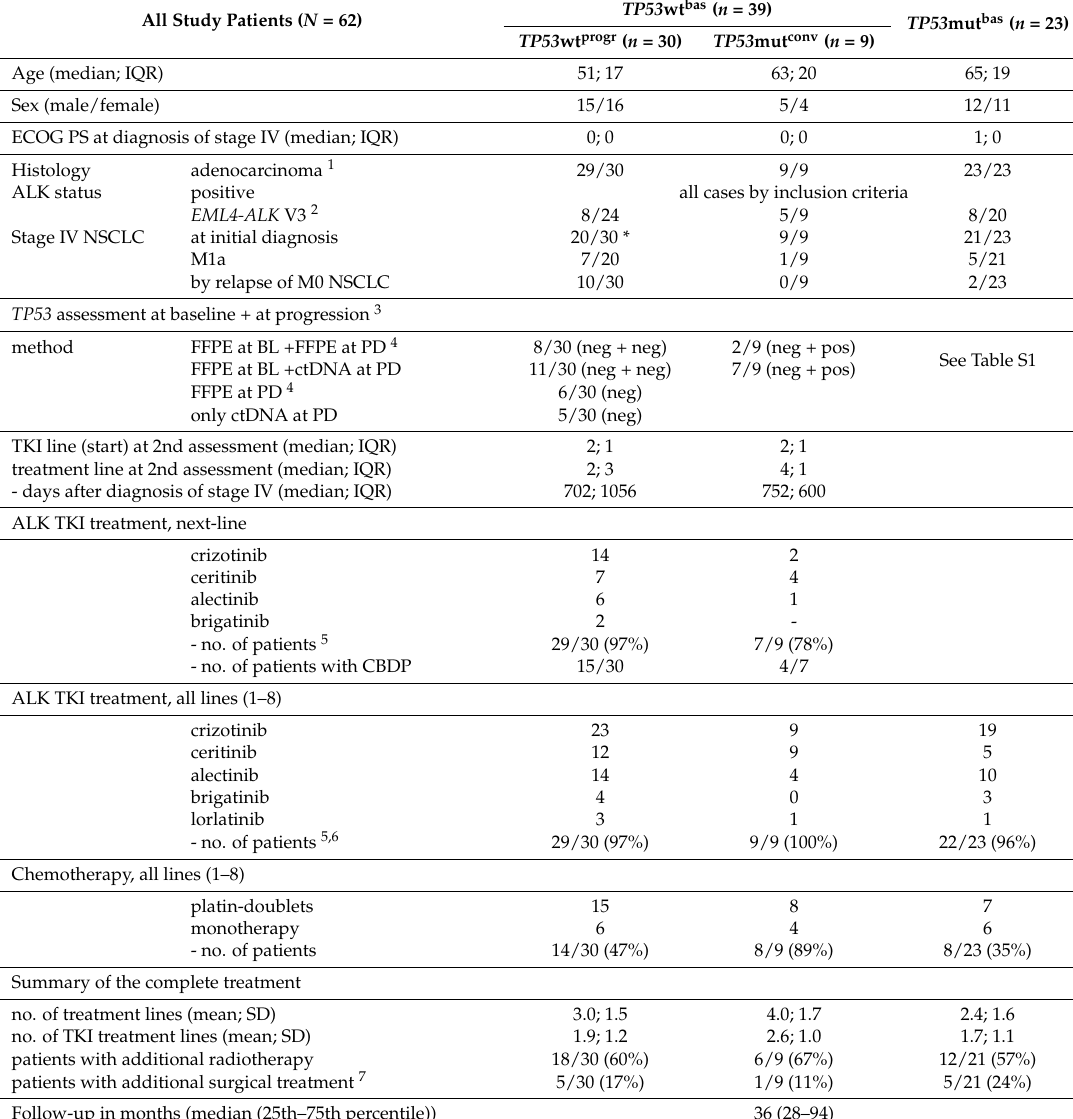
Table 1. Patient characteristics and details of